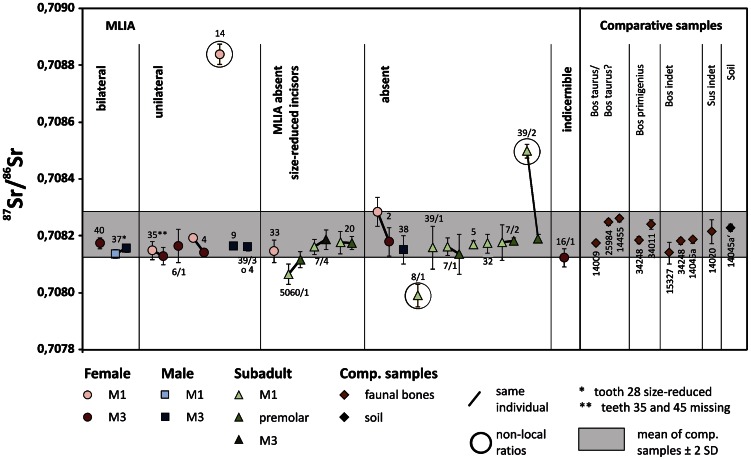
Sr-isotope compositions of tooth enamel (left) and comparative samples (right) from Basta.The former are plotted consecutively and show early and late mineralizing tooth pairs of individuals (highlighted with a tie-line) if applicable. Three individuals (14, 8/1, 39/2) plot clearly outside the ±2 SD local signal for Basta (shaded box: 0.70821±0.00008). Given the reported 87Sr/86Sr variation between ∼0.7053 and 0.7094 in modern food webs in the region [22], the observed overall variability for Basta is very small. In case of B39/2, only the first molar shows a non-local signature, which indicates that by the time of mineralization of the 2nd premolar (∼year 6), this individual had already moved to Basta. B5060/1 M1 is only marginally below the local Sr-isotope range, which is interpreted not to be significant, also because the Sr-isotope signal of its PM2 is consistent with Basta (even identifying B5060/1 as a non-local would not change any of the conclusions herein).